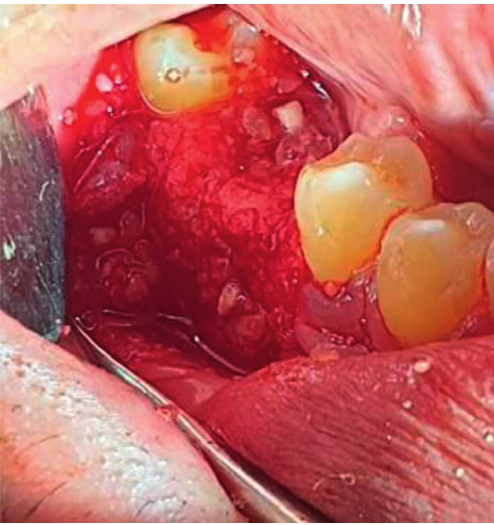
Figure 4: ATBG was used to augment the defective bone and the gaps between the socket boundaries and the implanted fixture.